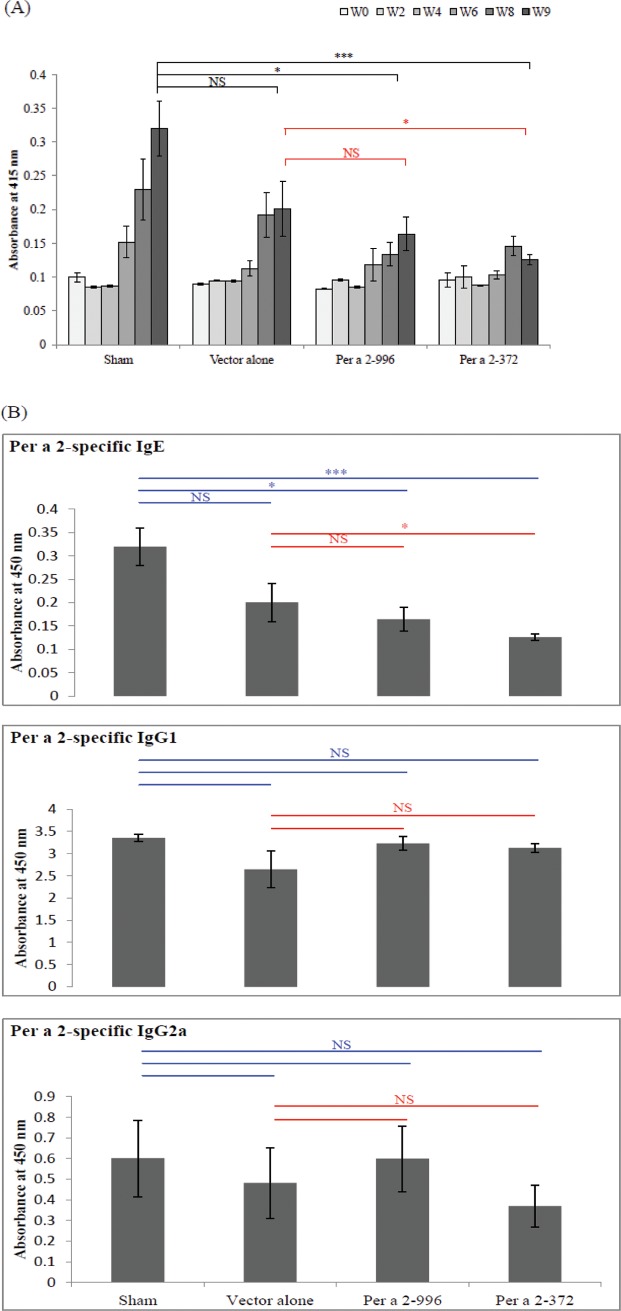
Specific antibody levels in Per a 2 sensitized mice.(A) Per a 2-specific IgE antibodies in the sera at the indicated weeks. (B) Serum levels of Per a 2-specific IgE, IgG 1 and IgG2a among groups at week 9 determined by ELISA. Results are mean±SEM of 5–6 mice from each group. *p<0.05; ***p<0.001 by one-way analysis of variance with the Bonferroni multiple range test.